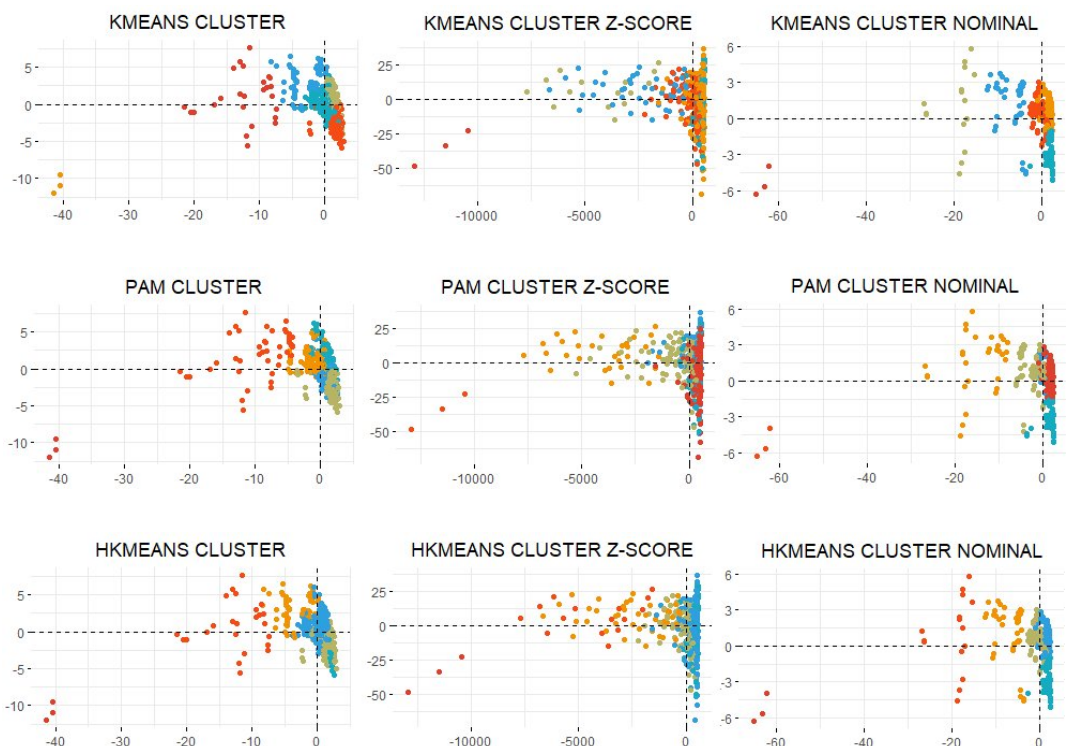
Figure 4. Representation of the results of the k-means, PAM, and hierarchical k-means algorithms for the different data sets. Source: authors’ own elaboration. Table 2. External and internal validation of clustering.